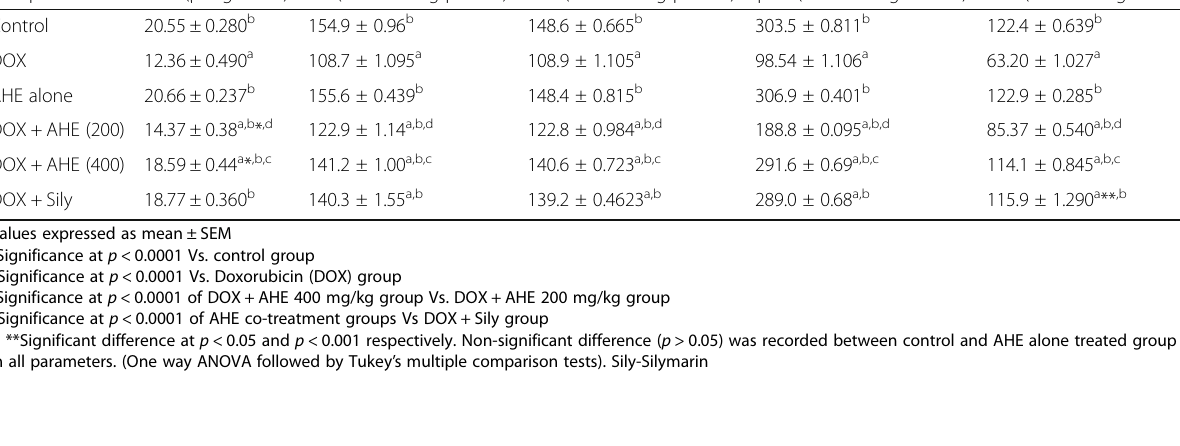
Table 5 Effect of Doxorubicin (DOX) and different treatments of AHE on cardiac enzymatic antioxidant levels and GSH profile